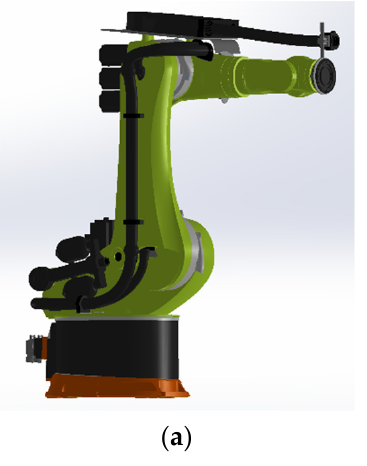
Figure 1. The 6-DOF robot and schematic diagram of its coordinate system. ( a ) 6-DOF robot; ( b ) Schematic diagram of coordinate system of 6-DOF robot.